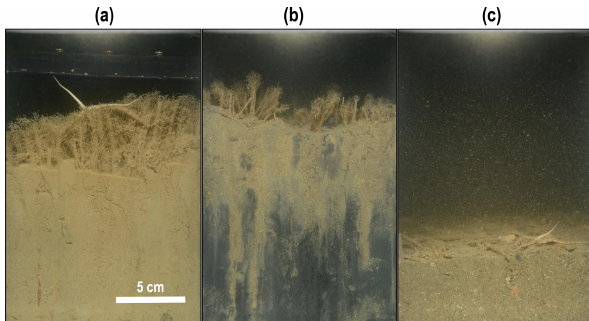
Figure 3. Examples of sediment profile imagery from the study showing a dense Lanice conchilega tubeworm reef (a) , bioirrigation-induced sediment oxidation (b) , and evidence of trawl disturbance: flattened tubeworms and sediment (c)